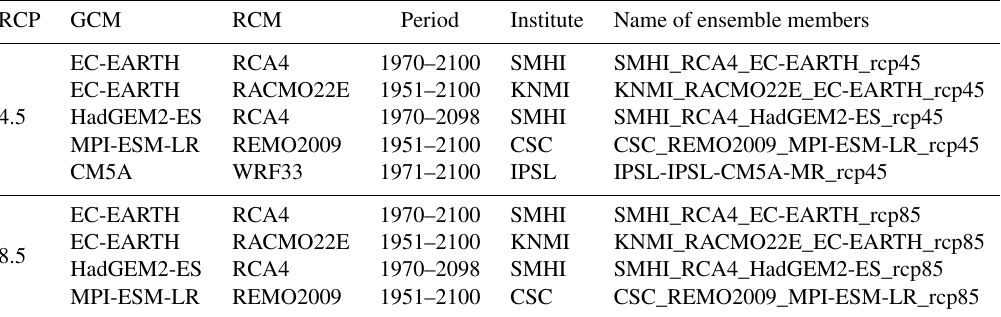
Table 1. Ensemble member characteristics from SWICCA portal. Modified from http://swicca.climate.copernicus.eu/wp-content/uploads/ 2016/10/Metadata_Precipitation_catchment.pdf (last access: 24 September 2019). RCP GCM RCM Period Institute Name of ensemble